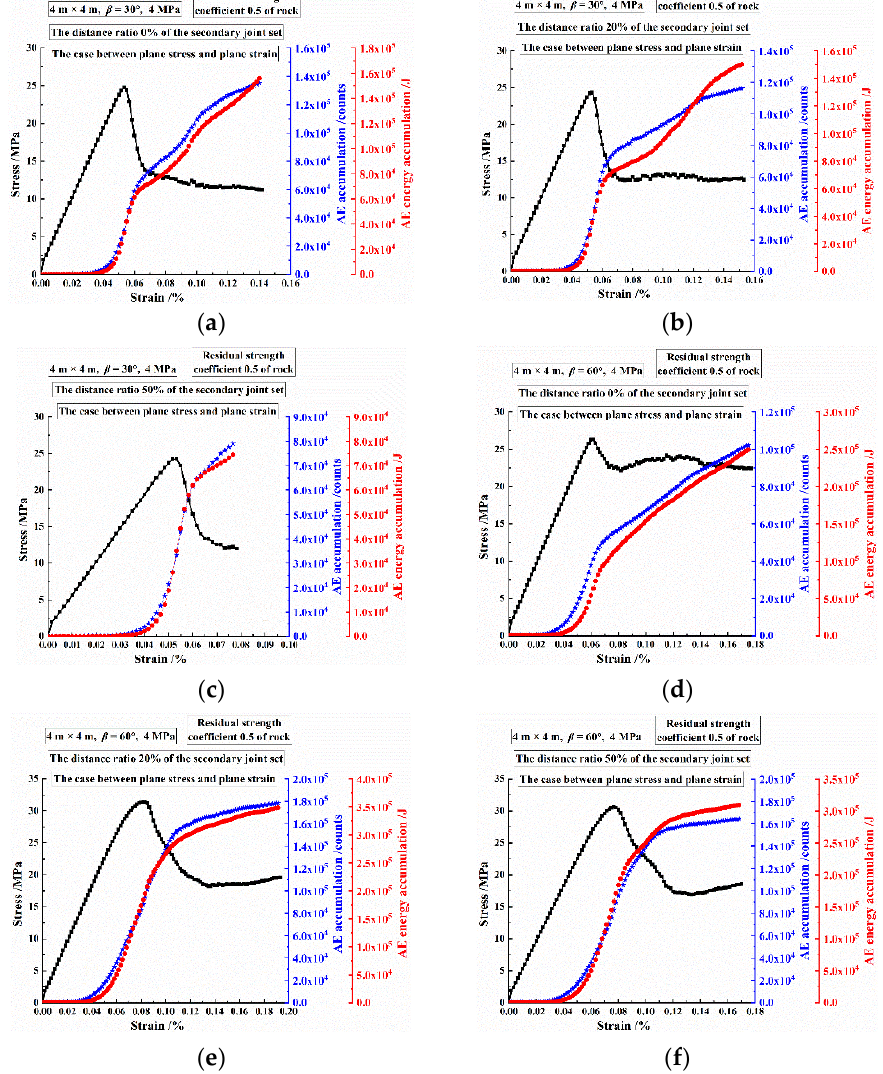
Figure 17. For the case between plane stress and plane strain, the AE counts and energy accumulations of the CJBs with different joint distance ratios: ( a – c ) for β = 30 ◦ and the joint distance ratios 0%, 20% and 50%, respectively; ( d – f ) for β = 60 ◦ and the joint distance ratios 0%, 20% and 50%,